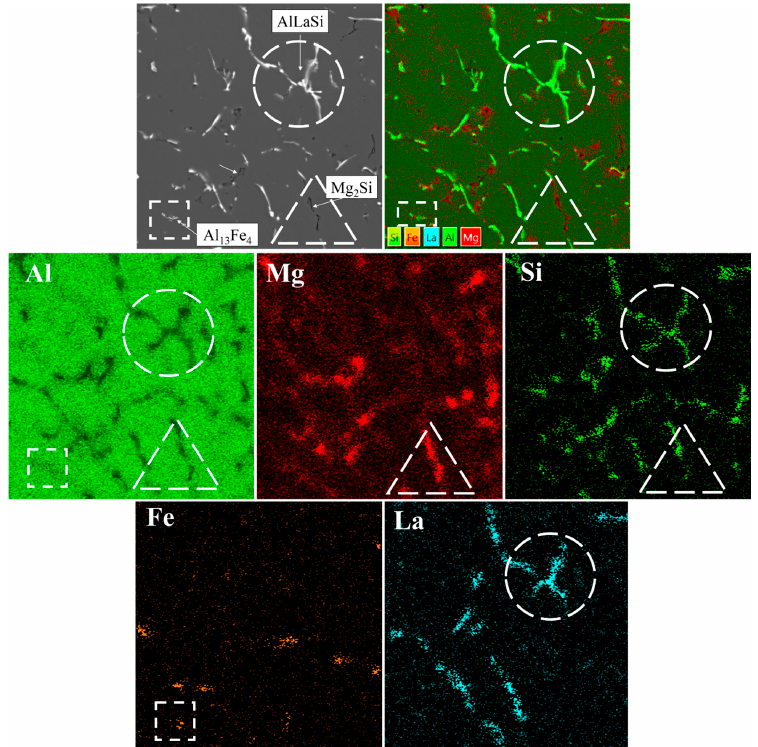
Figure 5. EMPA mapping (Al, Mg, Si, Fe, La) of the phases presented in the microstructure of the L4 alloy. L4